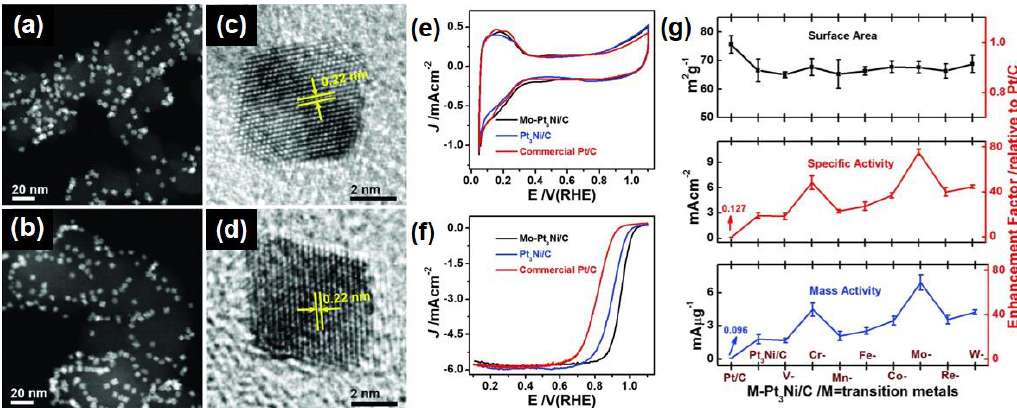
Figure 2. Transition metal doped octahedral Pt 3 Ni/C catalysts: ( a , b ) Typical high-angle annular dark field scanning transmission electron microscopy (HAADF-STEM) images of the ( a ) Pt 3 Ni/C and ( b ) Mo-Pt 3 Ni/C catalysts. High-resolution transmission electron microscopy (HRTEM) images of individual octahedral ( c ) Pt 3 Ni/C and ( d ) Mo-Pt 3 Ni/C catalysts. ( e ) Cyclic voltammograms of octahedral Mo-Pt 3 Ni/C, octahedral Pt 3 Ni/C, and commercial Pt/C catalysts recorded at room temperature in N 2 -purged 0.1 M HClO 4 solution with a sweep rate of 100 mV/s. ( f ) ORR polarization curves recorded at room temperature in an O 2 -saturated 0.1 M HClO 4 aqueous solution with a sweep rate of 10 mV/s and a rotation rate of 1600 rpm. ( g ) The electrochemically active surface area (top), area specific activity (middle), and mass specific activity (bottom) at 0.9 V versus RHE for these transition metal–doped M -Pt 3 Ni/C catalysts. Adapted from [65], with permission from AAAS, 2015.